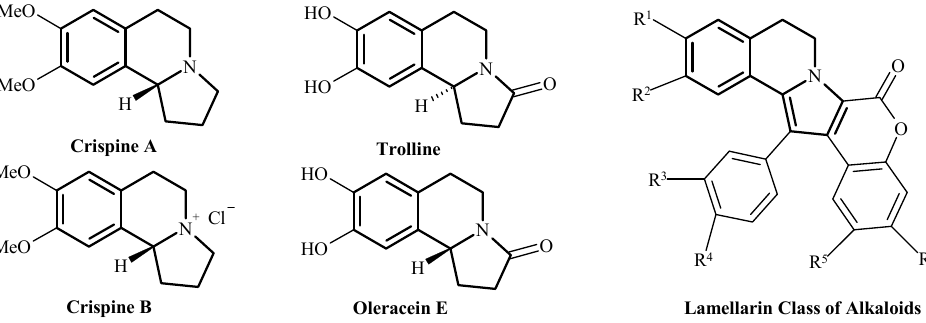
Figure 1. Natural alkaloids with pyrrolo[1,2- a ]isoquinoline